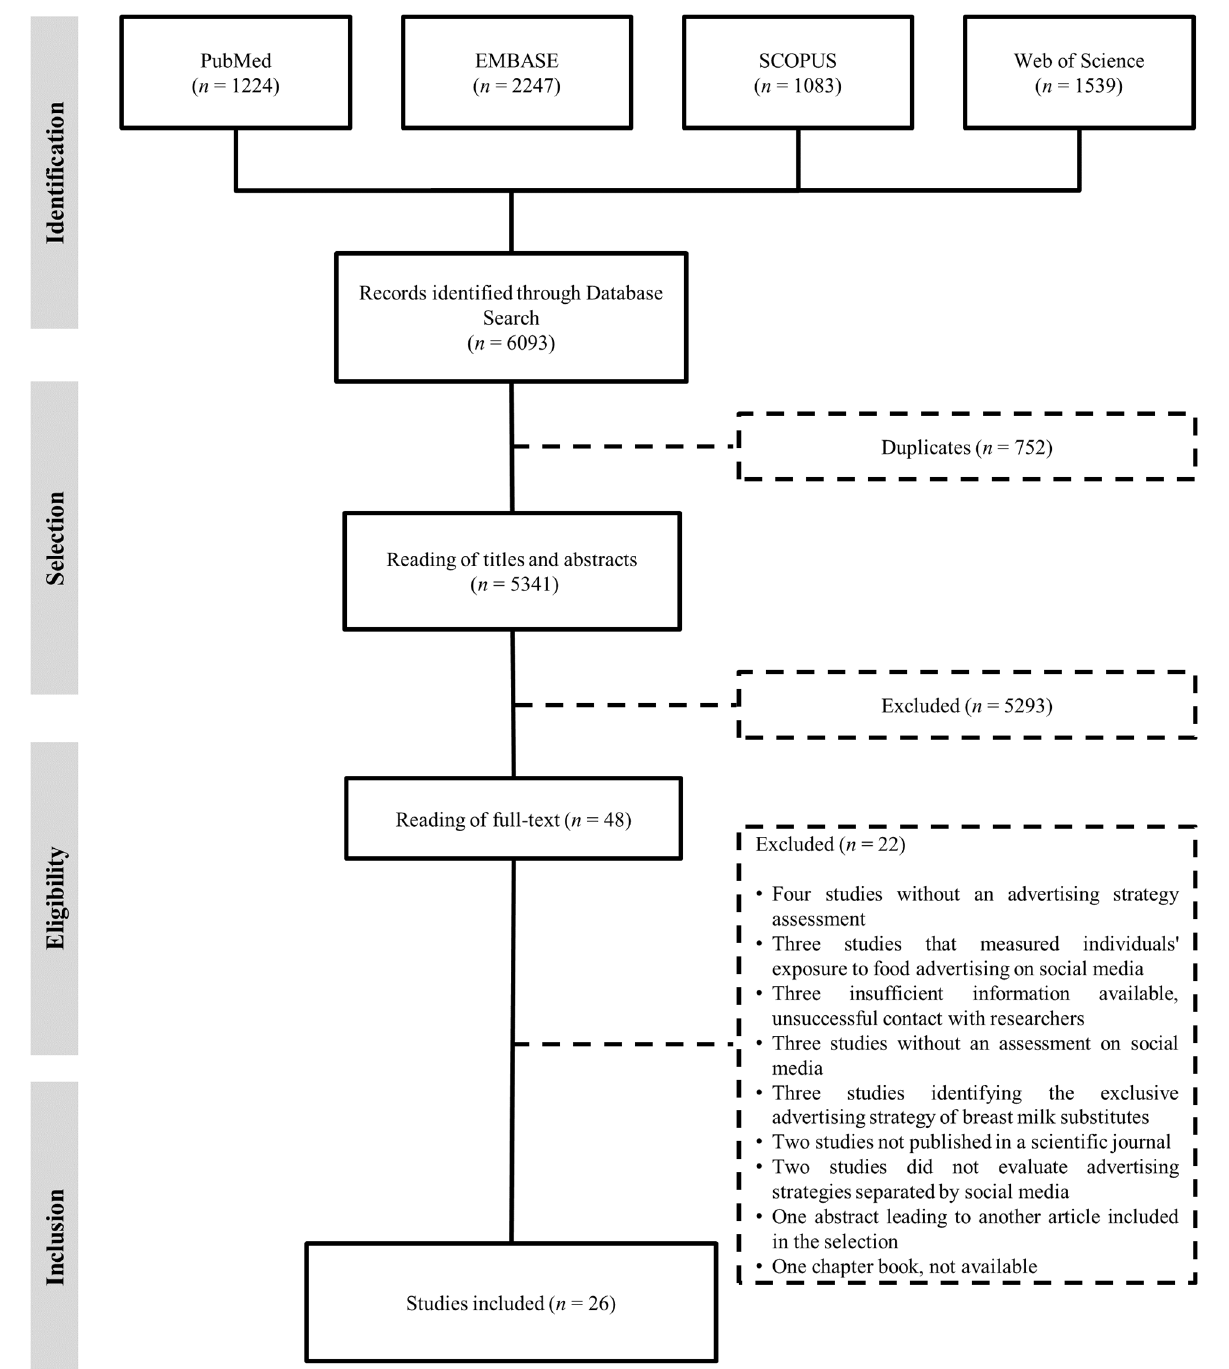
Figure 1. Flowchart showing the process of article selection (May